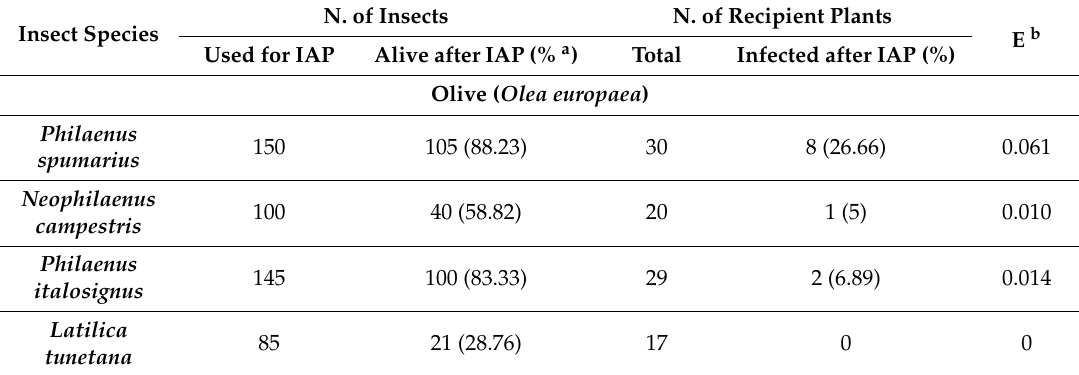
Table 1. Data collected from the six transmission experiments carried out in 2016 using specimens of di ff erent insect species caged for an acquisition access period of 96 h on Xylella fastidiosa infected olive trees. Number of insects and recipient olive plants used for the inoculation access period (IAP) are indicated.